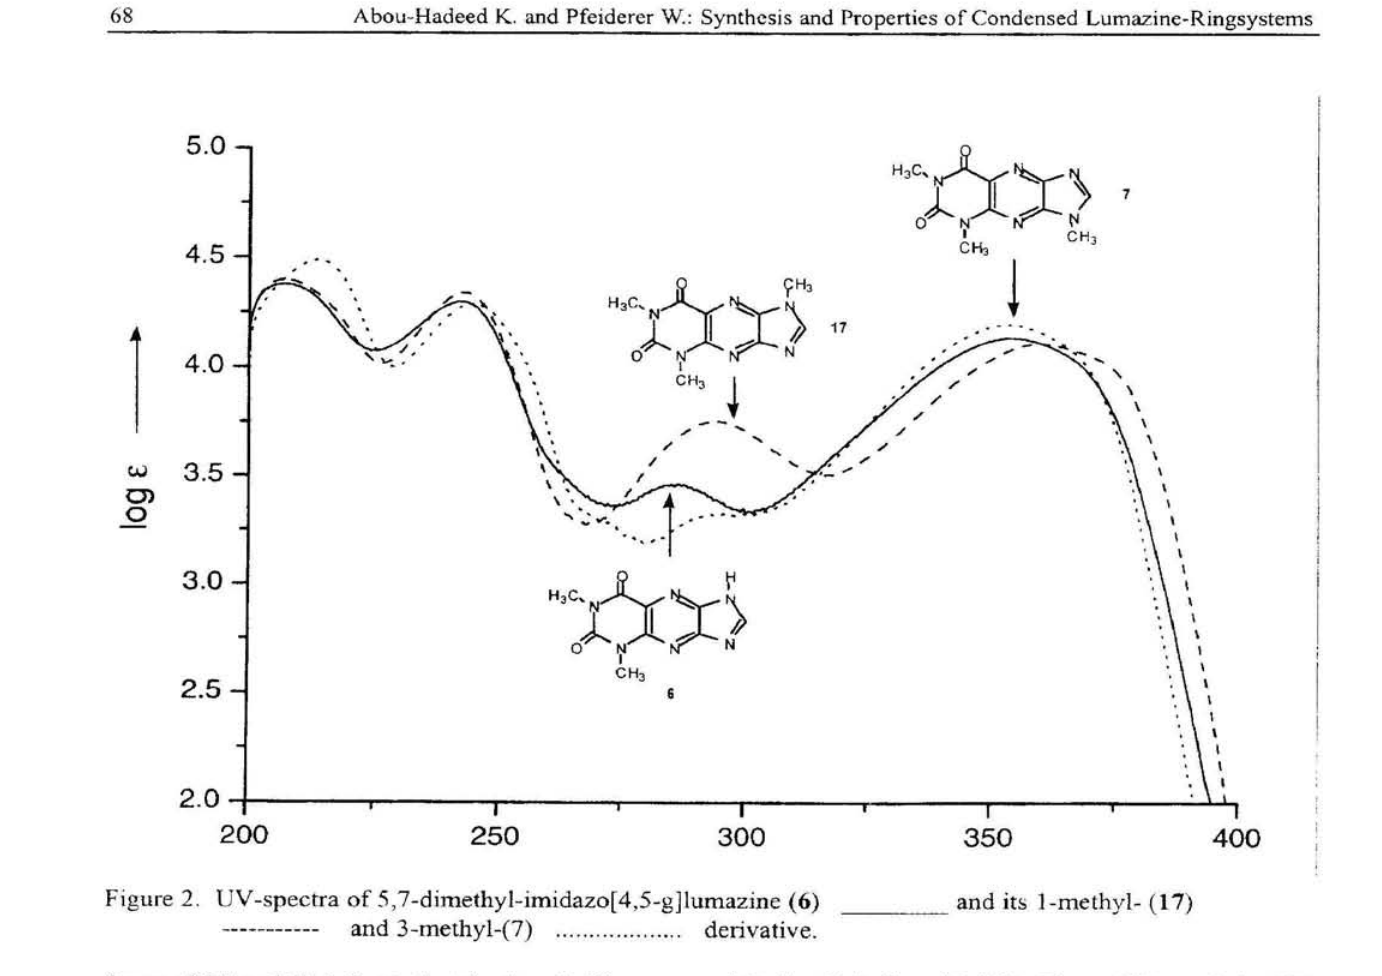
Figure 2. UV-spectra of 5,7-dimethyl-imidazo[4,5-g]lumazine (6) and its 1-methyl-(17) and 3-methyl-(7)